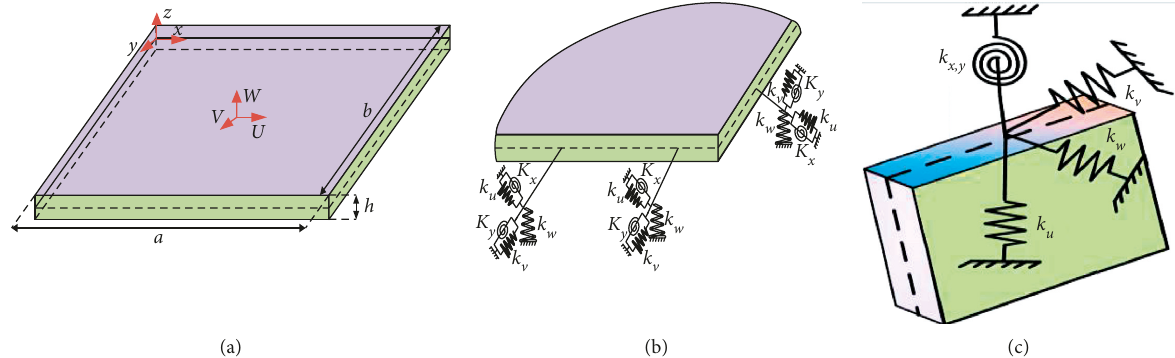
Figure 1: Geometric characteristic symbols and coordinates of porous rectangular plates: (a) the outline and coordinates; (b) the edge restraints; (c) translational and rotational spring of differential